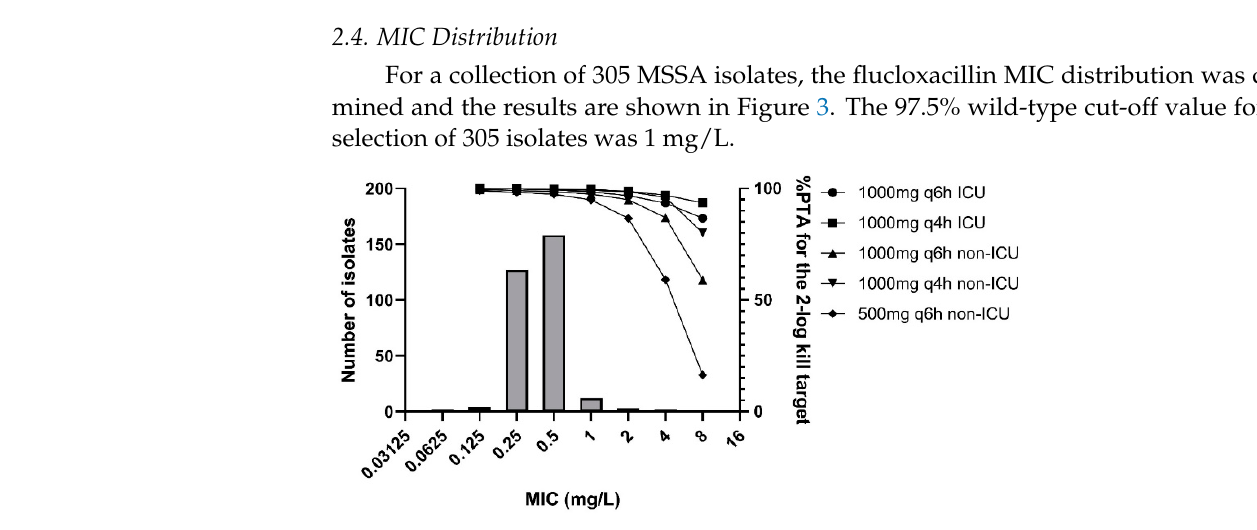
Figure 3. Distribution of MSSA isolates and the probability of target attainment (%PTA) for the 2- log kill target for several dosing regimens for intensive care unit (ICU) [7] as well as non-ICU hos- pitalized patients